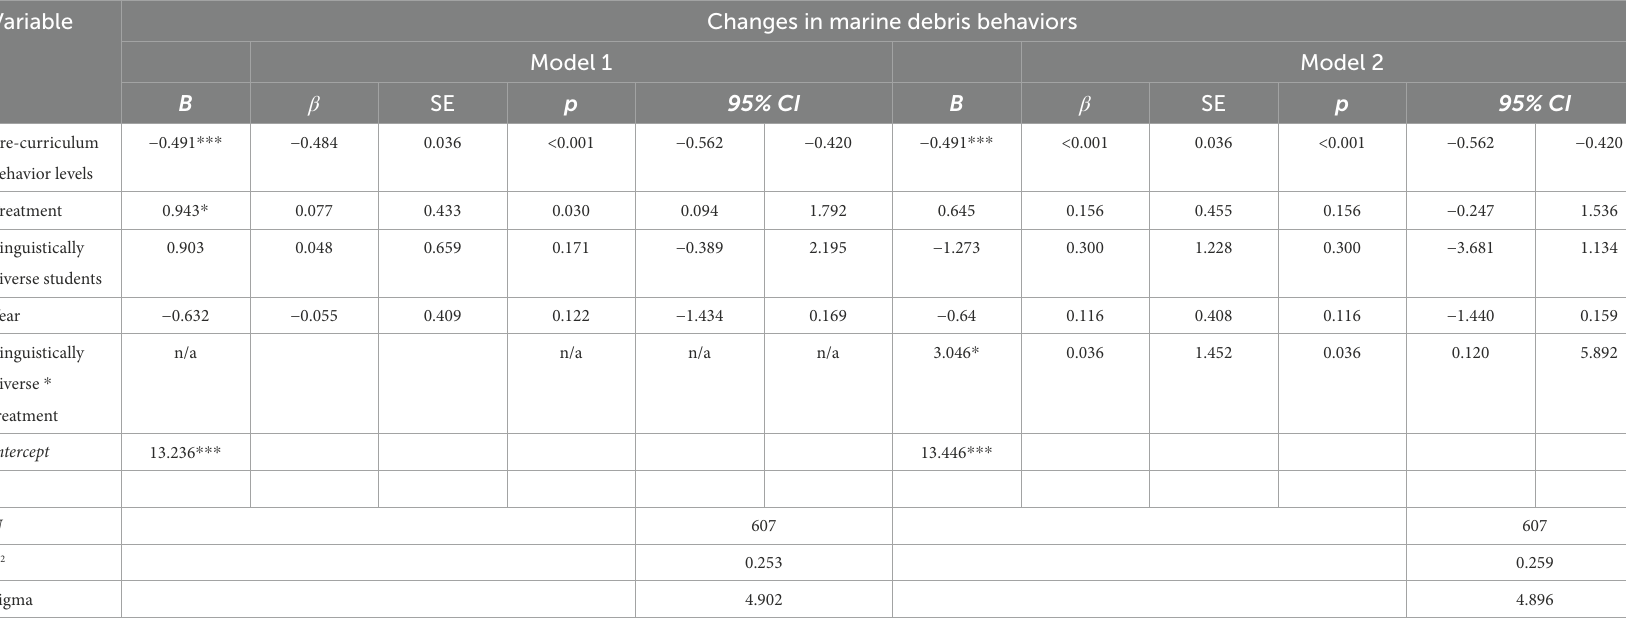
TABLE 3 Changes in marine debris behavior as predicted by behavior pre-test scores, treatment group membership, linguistic diversity, and year of participation. Model 1 displays treatment effects for the entire sample, and model 2 includes an interaction term to detect differential treatment effects among linguistically diverse students.